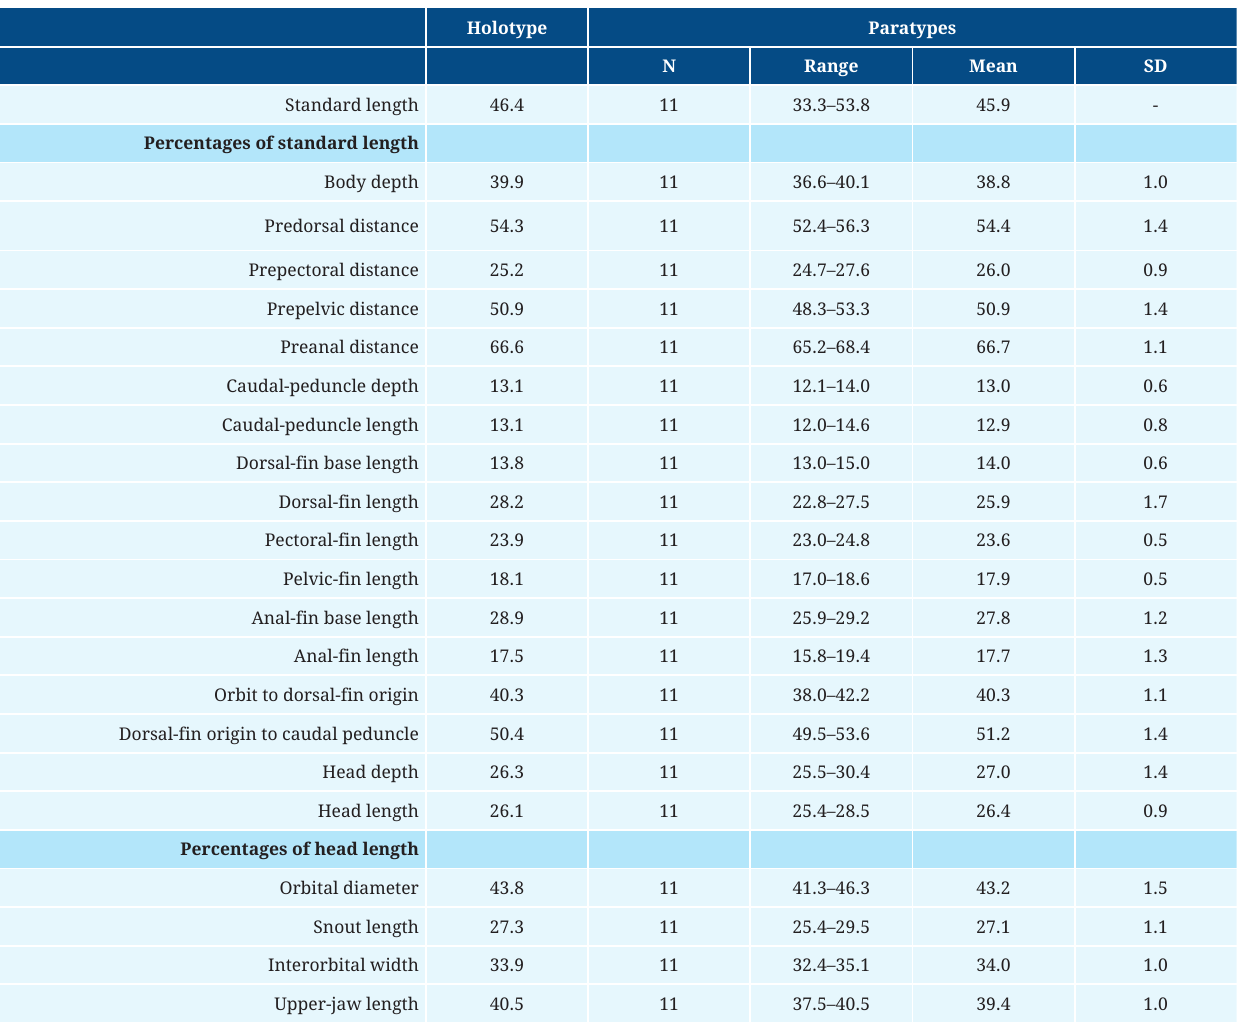
TABLE 3 | Morphometric data of Knodus obolus. SD = standard deviation; N = number of Holotype Paratypes